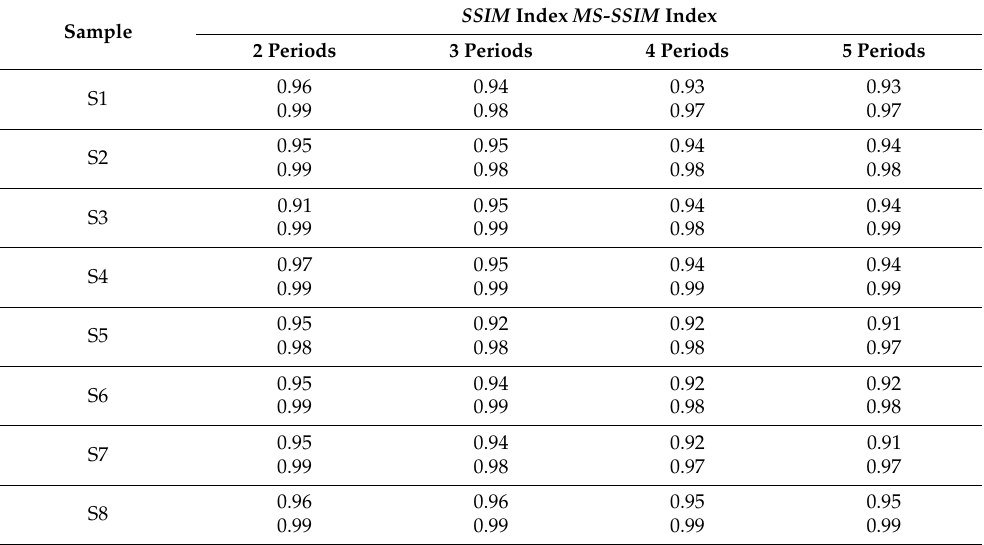
Table 3. Comparation of phase images for all measurement in the case of a flash lamp as source of